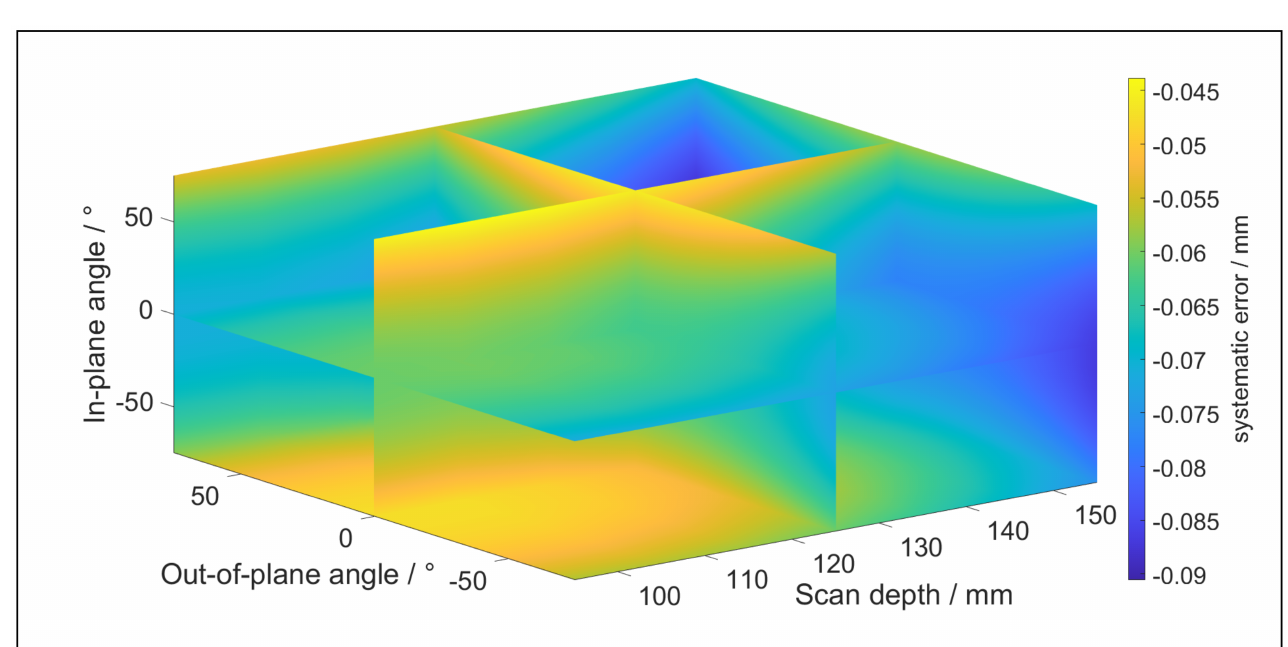
Figure 10. The systematic error of the LLS for stainless steel surfaces in function of the measurement strategy.